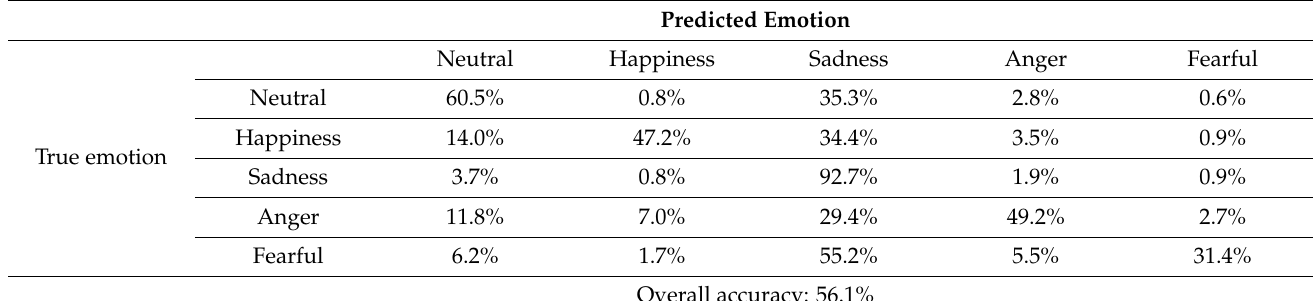
Table 3. Confusion matrix of the emotion classification results of the proposed cascaded DnCNN–CNN that was trained on the Korean CADKES mixed with the PCAFETER noise.